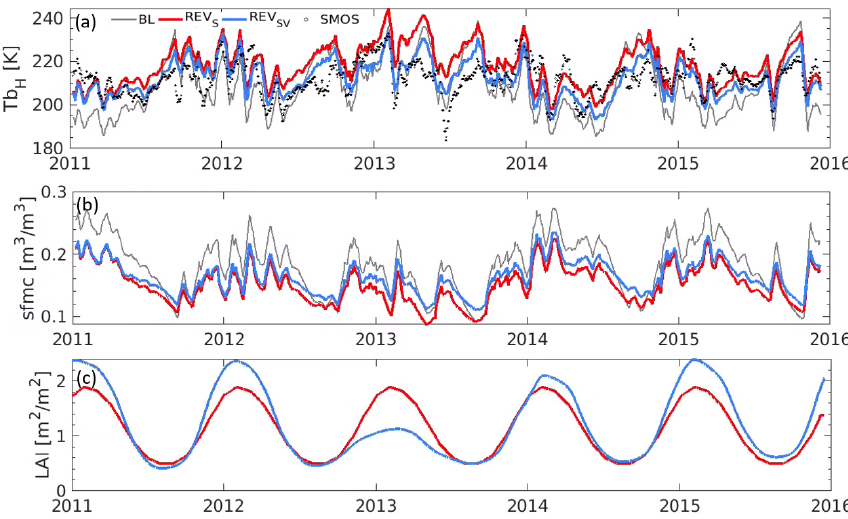
Figure 12. Time series of simulated (gray) BL, (red) REV S , and (blue) REV SV NOAH-based (a) T b location as in Fig. 6 but upscaled to the 36km EASEv2-grid resolution. Also shown are (black dots) SMOS observed T b